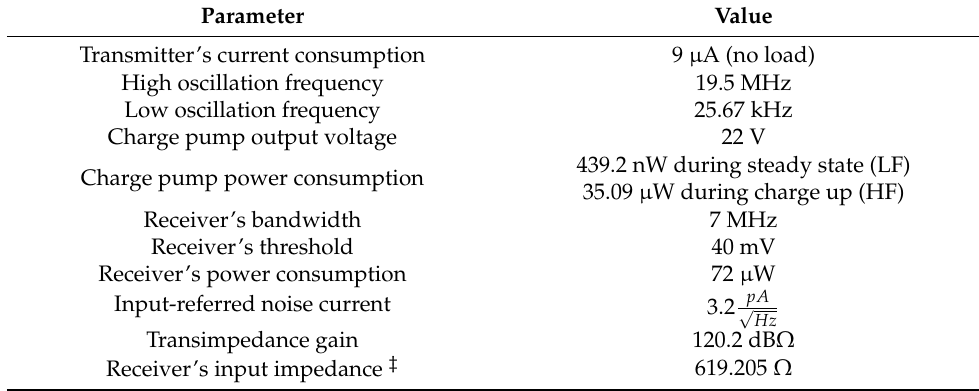
Table 1. Measured performance metric of the fabricated IC.